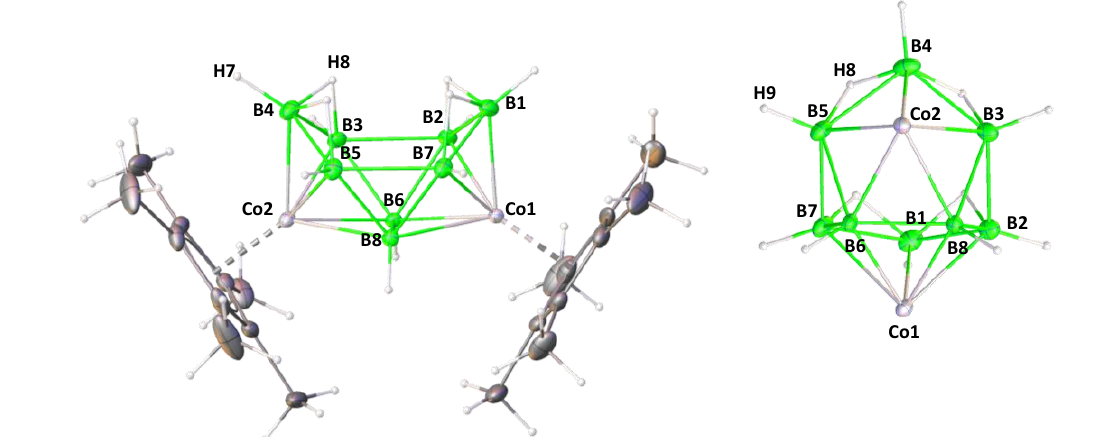
Figure 5. Molecular structure and atom labels for 2 : frontal view (left) and bottom angular view (right, Cp* ligands attached to Co are omitted for clarity). Selected bond lengths (Å) and bond angles ( ◦ ): B1–Co1 1.972(5), B2–B3 1.971(7), B2–Co1 2.043(5), B3–B4 1.807(8), B3–Co2 2.043(4), B5–Co2 2.041(5), B7–Co1 2.046(4), B3–B2–Co1 115.5(2), B4–B3–B2 116.3(4), B3–B4–B5 103.9(3), and B2–Co1–B7 89.1(2). Table 2. Experimentally observed and calculated 1 H and 11 B chemical shifts for 2 – 4 species and 2′ – 4′ models, respectively. Table 1. Selected structural and spectroscopic parameters of 10-vertex−12-SEP nido -cobaltaborane clusters. a 1 H NMR δ (ppm) 11 B NMR δ (ppm) Cluster Expt. Geometry